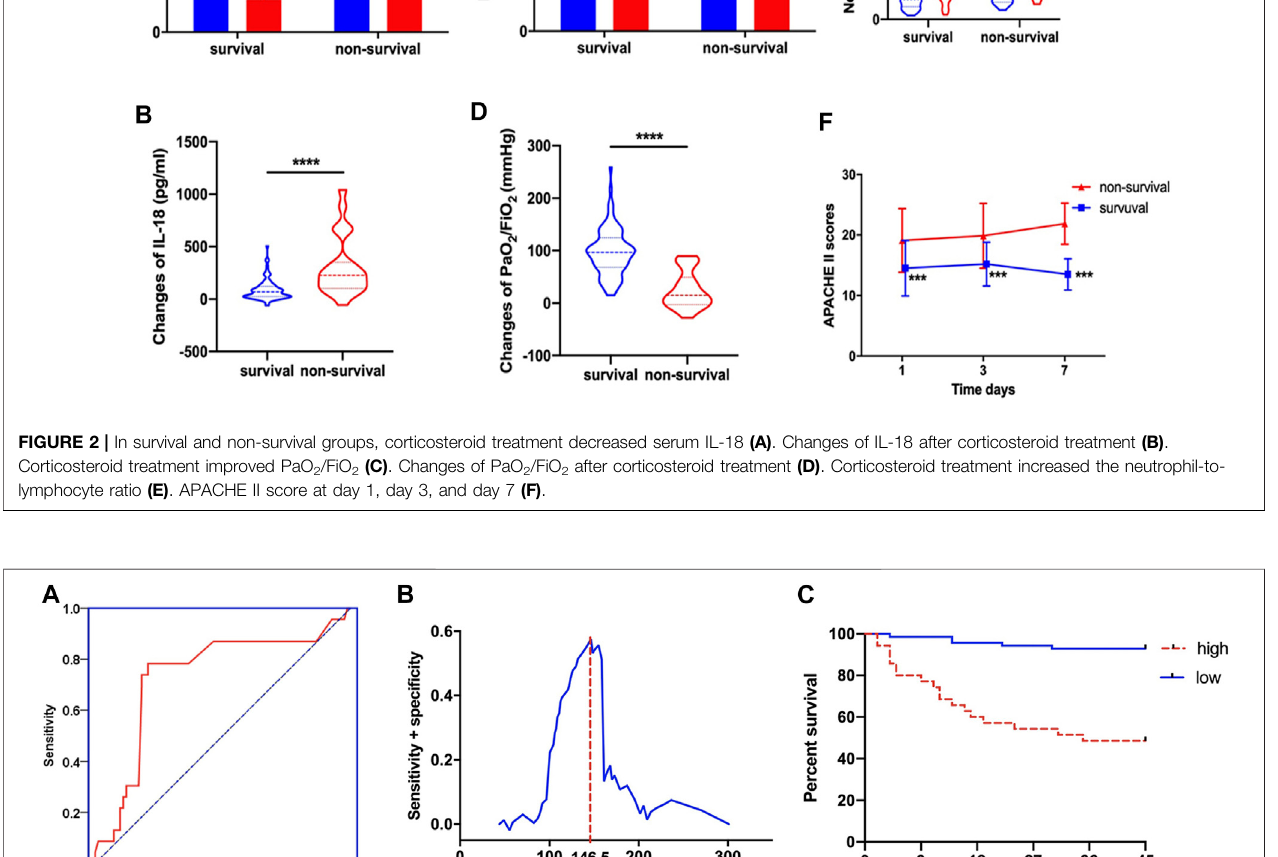
FIGURE 3 | The regression model between corticosteroid treatment and mortality for ROC curve (A) . Sensitivity and speci fi city analysis of mortality in different doses of corticosteroid treatment (B) . Kaplan – Meier method to analyze the 45-day mortality (C) in the high-dose and low-dose corticosteroid treatment groups.